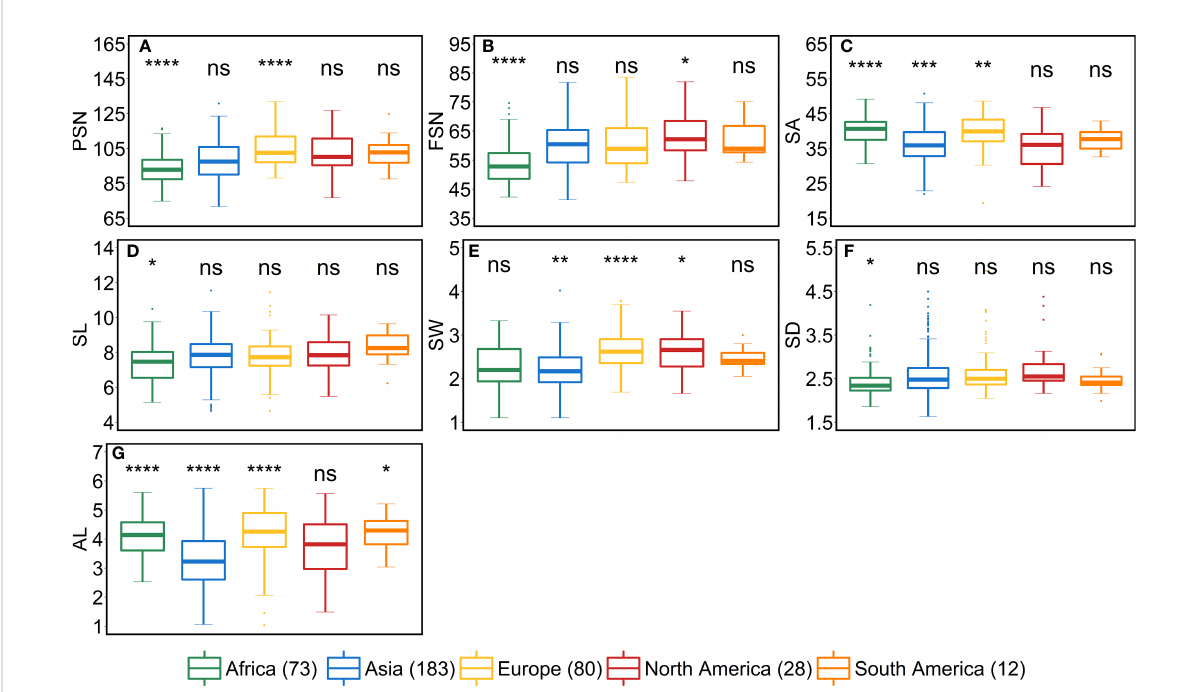
FIGURE 5 Comparison of accessions according to their geographical origin for the spike traits. (A) potential spikelet number (PSN), (B) fi nal spikelet number (FSN), (C) spikelet abortion (SA in %), (D) spike length (SL in cm), (E) spike weight (SW in g), (F) spike density (SD) and (G) awn length (AL). ‘ n ’ denotes the number of accessions in this panel and the number of the accessions belonging to each continent; ****, ***, **, and * = signi fi cance level at the 0.0001, 0.001, 0.01, and 0.05 probability level, respectively and ‘ ns ’ represents insigni fi cant differences and the legend represents different